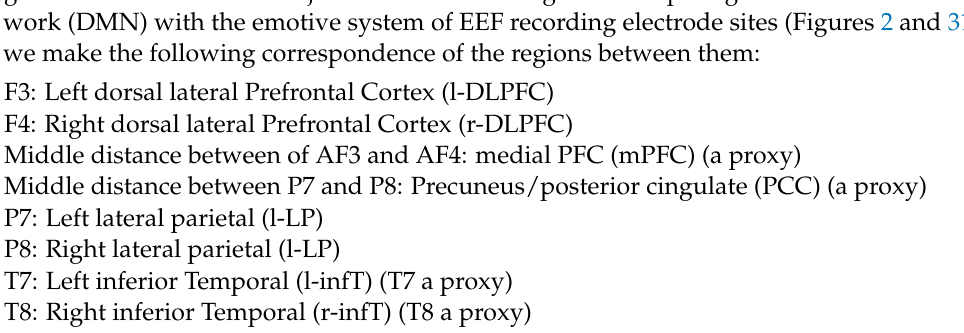
F3: Left dorsal lateral Prefrontal Cortex (l-DLPFC) F4: Right dorsal lateral Prefrontal Cortex (r-DLPFC) Middle distance between of AF3 and AF4: medial PFC (mPFC) (a proxy) Middle distance between P7 and P8: Precuneus/posterior cingulate (PCC) (a proxy) P7: Left lateral parietal (l-LP) P8: Right lateral parietal (l-LP) T7: Left inferior Temporal (l-infT) (T7 a proxy) T8: Right inferior Temporal (r-infT) (T8 a proxy)